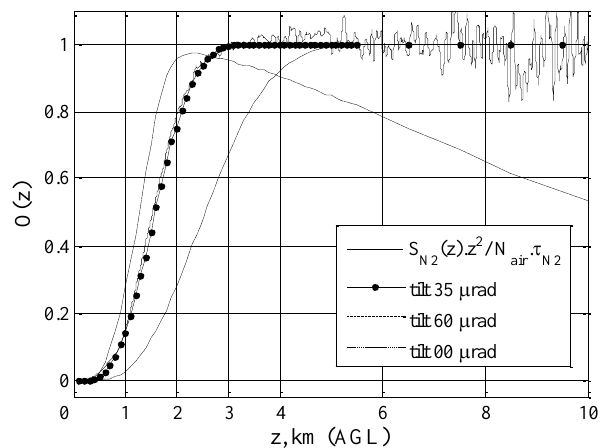
Fig. 4. Calculated overlap functions for different mirror tilt angles, compared to derived from acquired nitrogen signal overlap function. The overlap functions were calculated for the telescopes focused at 10 km (0.1 mm fiber shift away from the mirrors), whereas the over- lap estimate uses nitrogen signal recorded on 9 July 2008, averaged for 1 min (1800 laser shots) and over 37.5 m (10 bins).